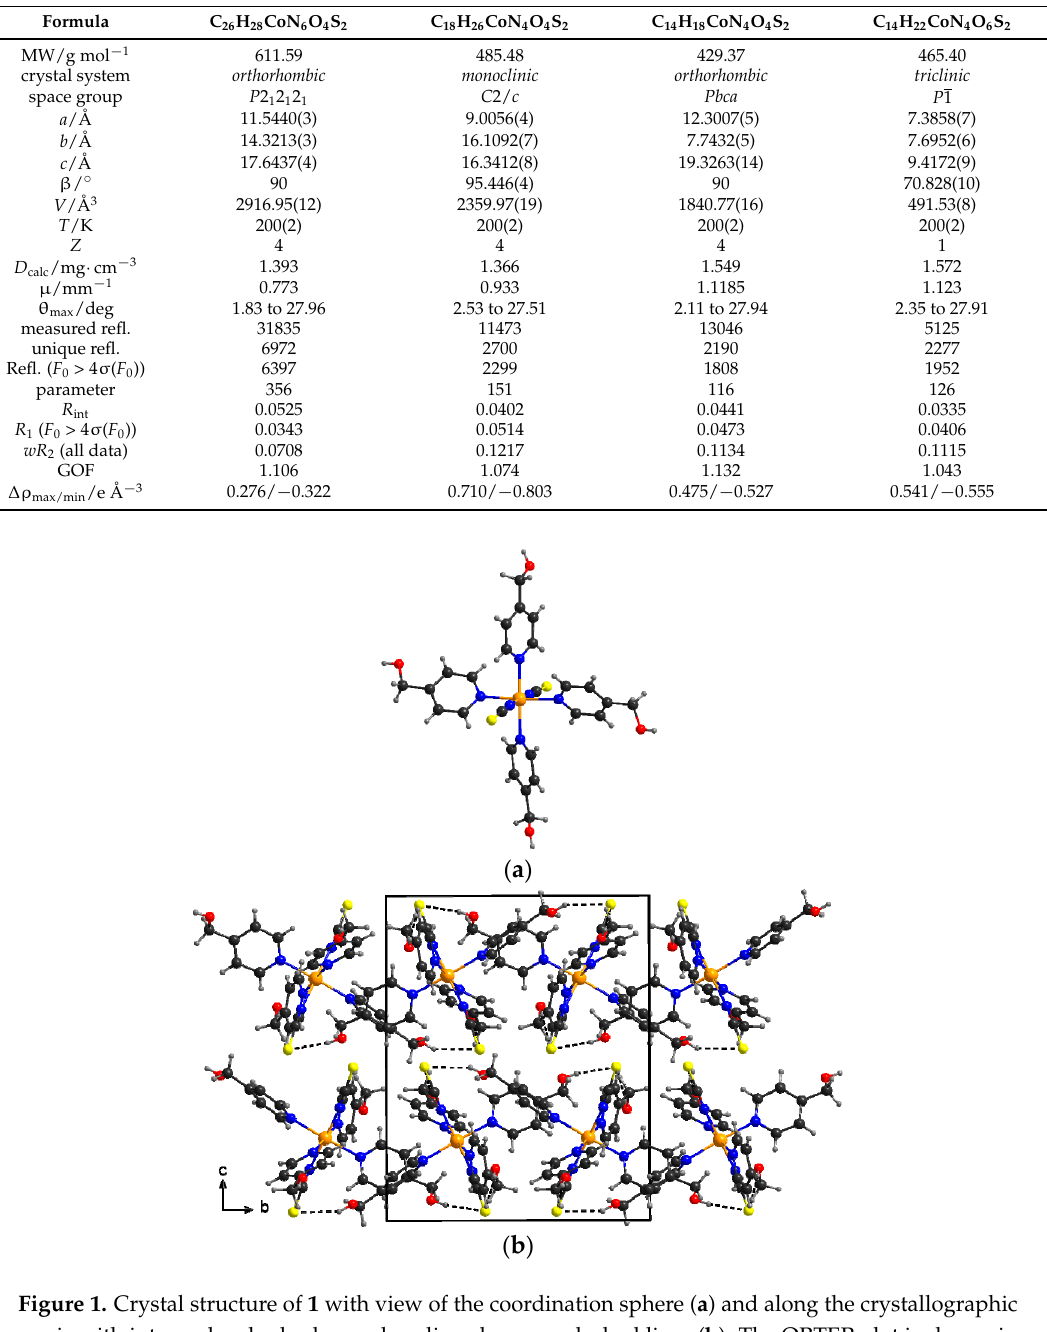
Table 1. Selected crystal data and details on the structure determinations for compounds 1 , 2 , 3 and 4 . Compound